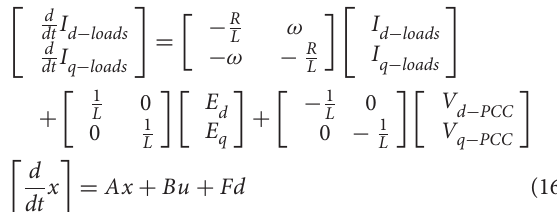
Frontiers in Energy Research |